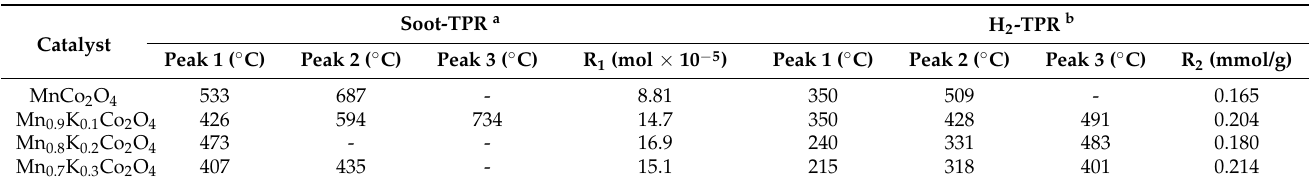
Table 3. The temperature of each peak in the Soot-TPR and H 2 -TPR curves over as-prepared monolith catalysts.